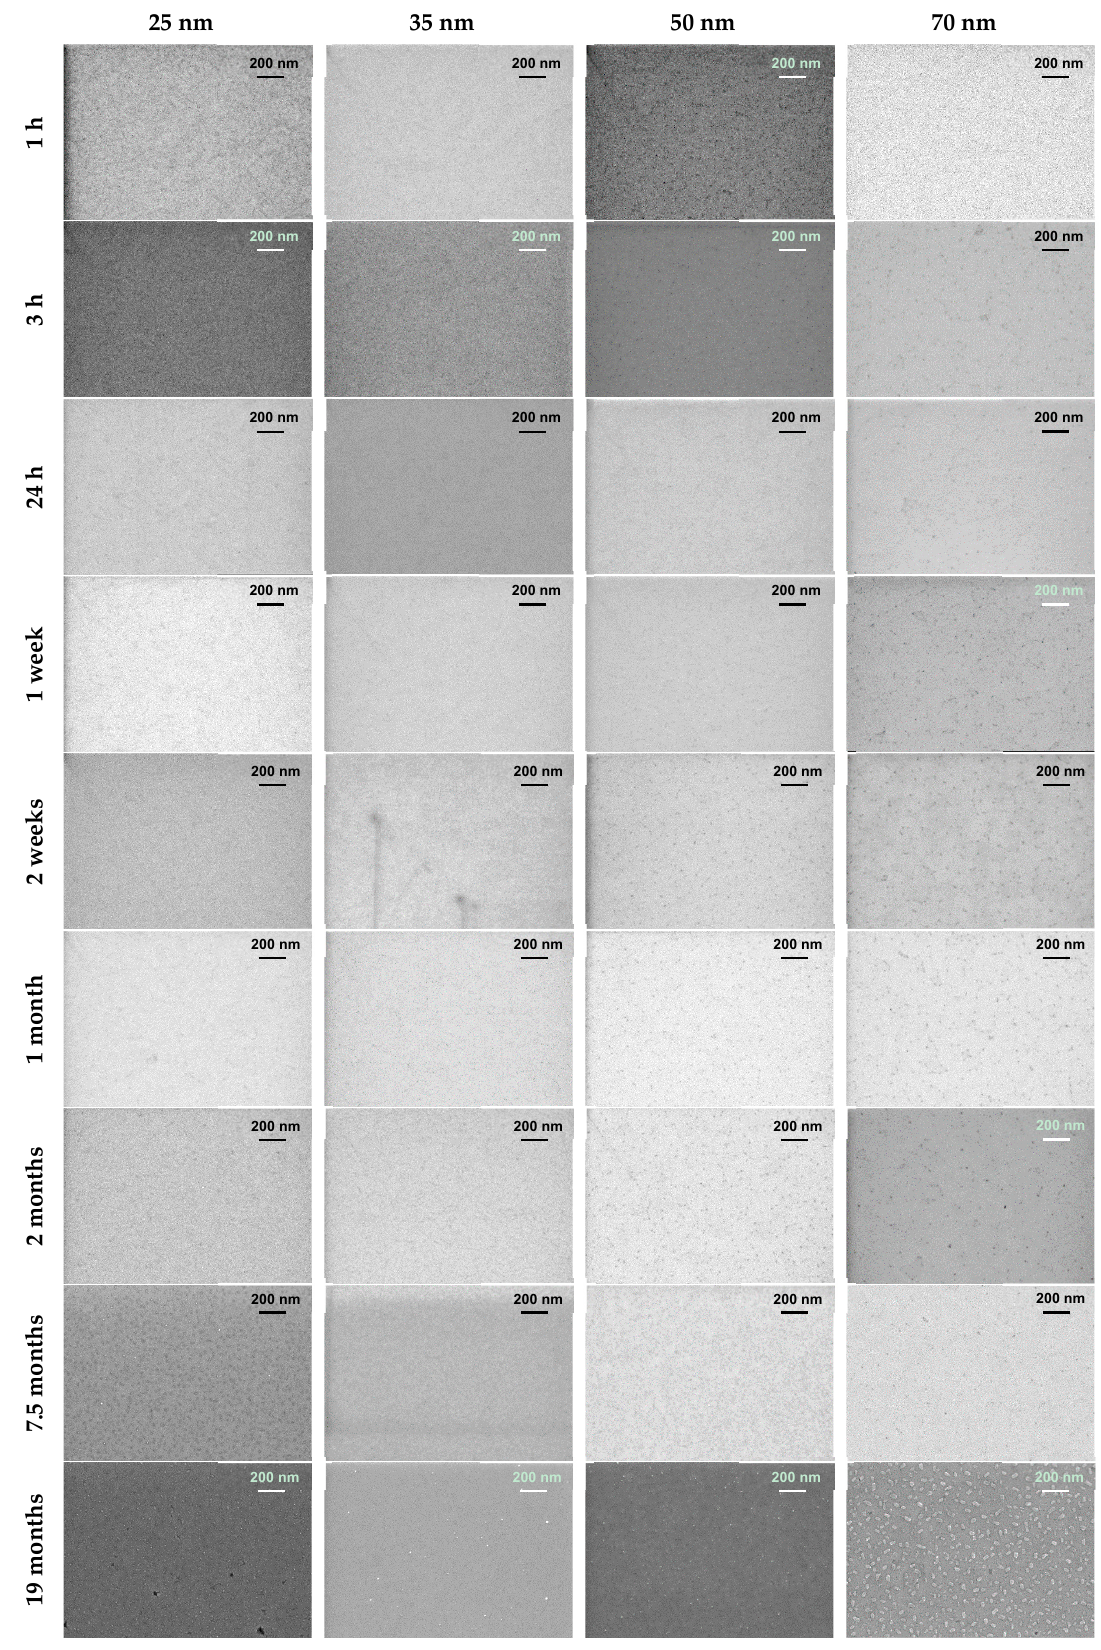
Figure 2. Over-time SEM surface images of the films (50,000× magnification).